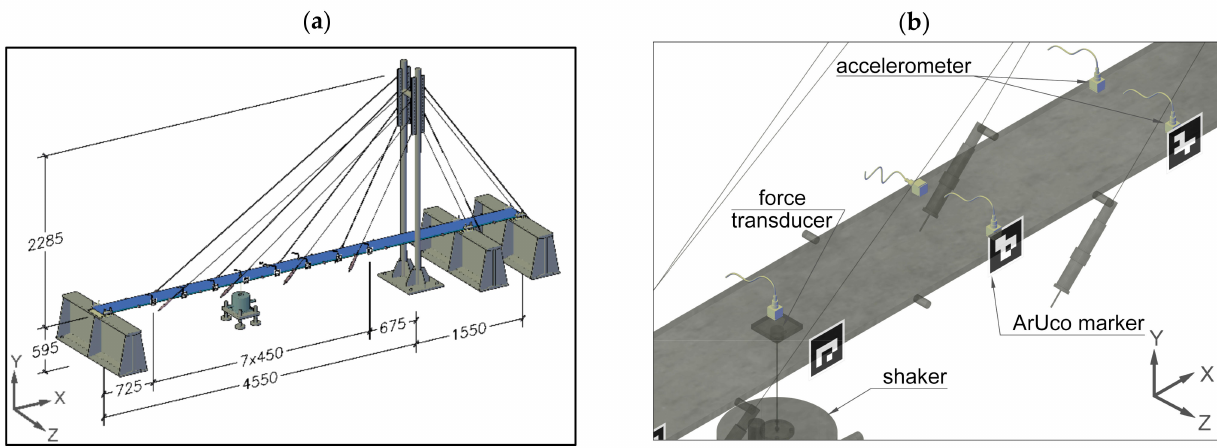
Figure 2. Layout of the bridge model and instrumentation systems; ( a ) overview, ( b ) zomed-in section of the deck near the shaker attachment. All dimensions in mm. In modal analysis, the performance of the bridge model in XY plane only was of